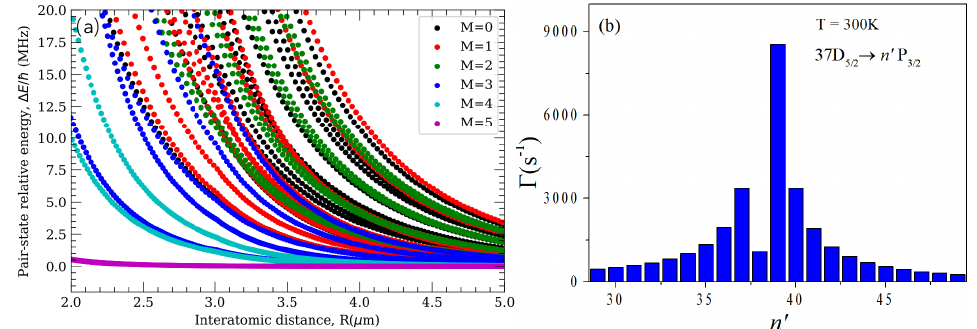
Figure 3. ( a ) The calculated interaction potential of 37 D 5/2 pair for | M | = 0–5, indicating that the interaction is anisotropic for different | M | , where M = m j 1 + m j 2 , m j 1 and m j 2 are the magnetic quantum numbers of atom 1 and 2, respectively. At the Rydberg atomic density of ∼ 10 9 in this work, the interaction curves display repulsive potentials. ( b ) Calculations of the BBR-induced decay rates of 37 D 5/2 → n (cid:48) P 3/2 transitions at T = 300 K. The transition of 37 D 5/2 → 39 P 3/2 has the largest decay rate of ∼ 9000 s − 1